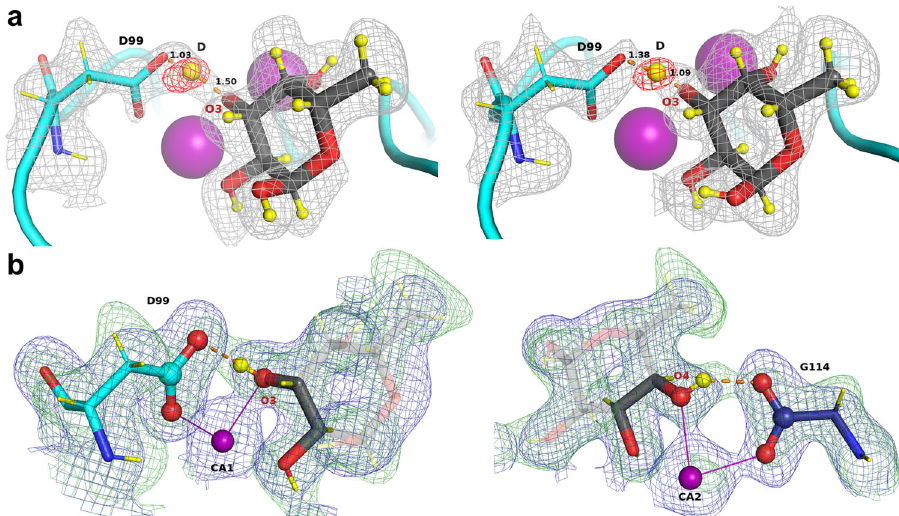
Fig. 4 Mechanistic details of the proposed synergistic interactions involving hydrogen bonds and metal coordination. a A low-barrier hydrogen bond in chain A (left) and D (right) located from the omit difference m F o -D F c neutron map (red mesh) in the vicinity of O3 of fucose. b Two six-membered rings (illustrated by atoms in sphere representation) formed by proposed synergistic interactions between fucose, calcium, and LecB. Hydrogen bonds are shown as orange dashed lines and metal coordination as solid purple lines. Deuterium atoms are shown as yellow spheres and yellow sticks. The 2m F o -D F c neutron map (green mesh) is contoured at 1 σ . The 2m F o -D F c X-ray map (blue mesh) is contoured at 1.2 σ